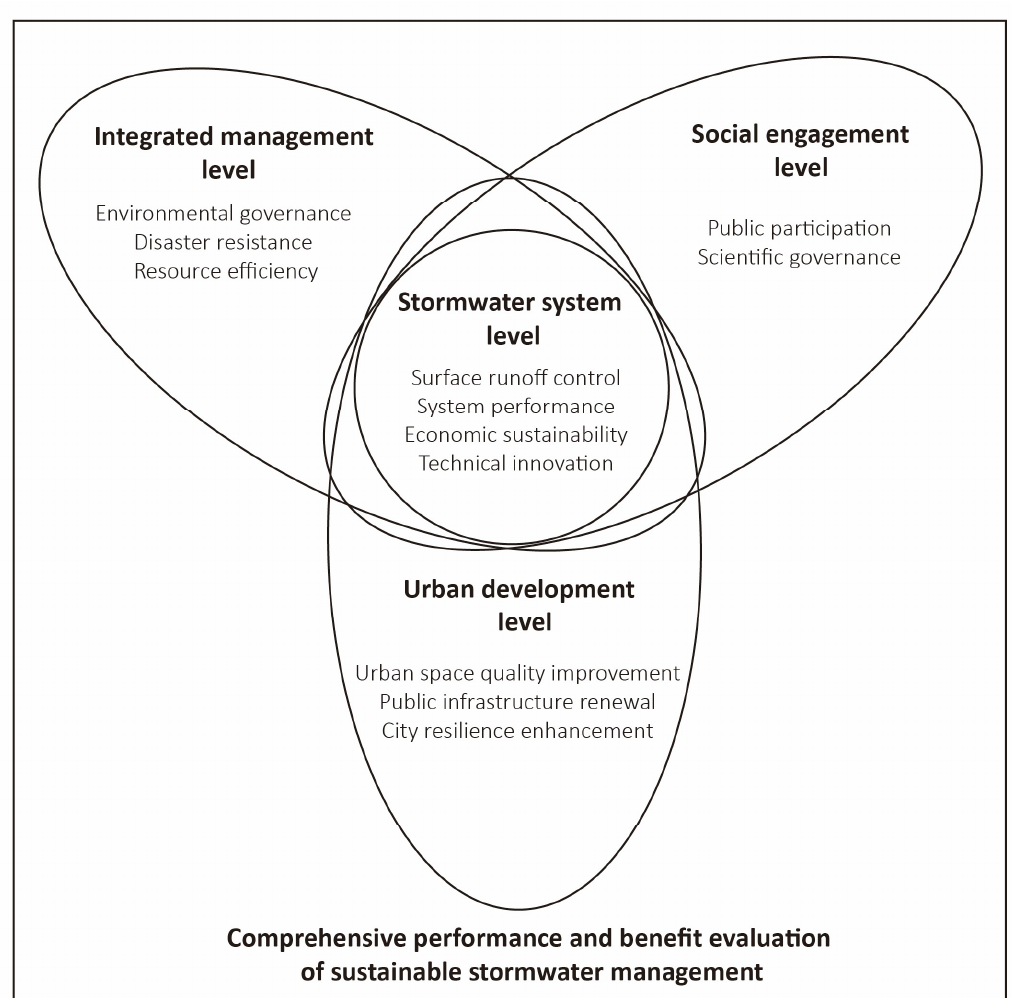
Figure 3. The relationship between each level of objectives in the comprehensive evaluation framework for SSWM.